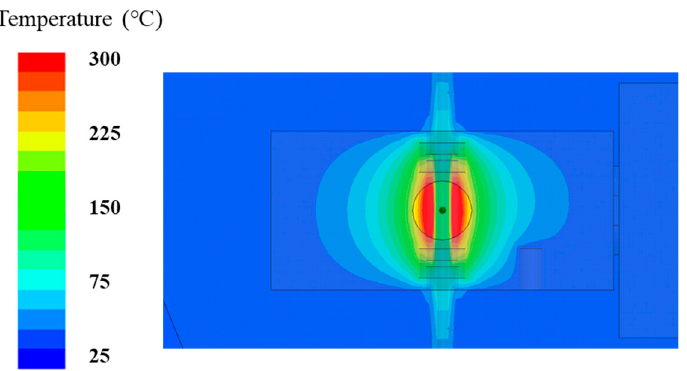
Figure 3. The simulation result of the TM-mode cavity’s thermal field with the microwave power = 20 W.